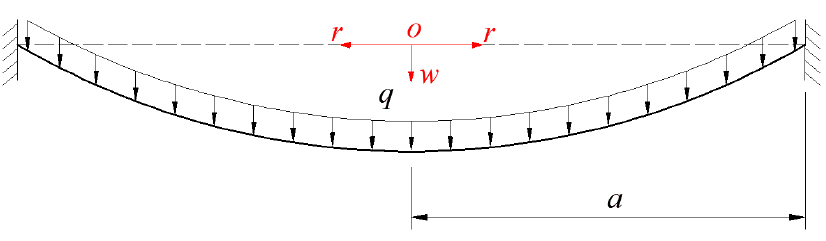
Figure 5. Sketch of the circular membrane under transverse loads q .